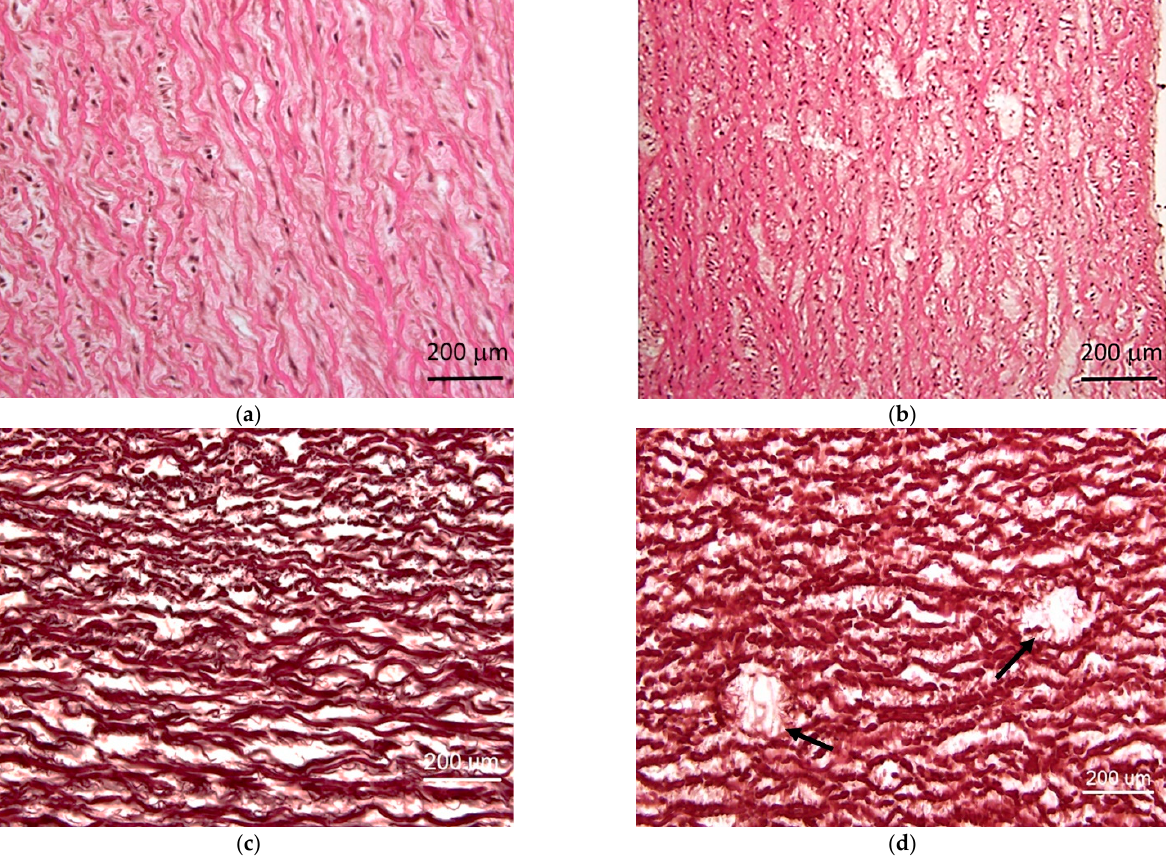
Figure 11. Microscopic images of aortic walls treated with laser beam. The images show: ( a ) mild and ( b ) severe degree of stromal damage with partial cell loss and disorganization (HE staining); ( c , d ) specimens stained for elastic elements showing mild ( c ) and severe ( d ) fragmentation of elastic lamellae and focal tissue disintegrations (marked with arrows in ( d )).